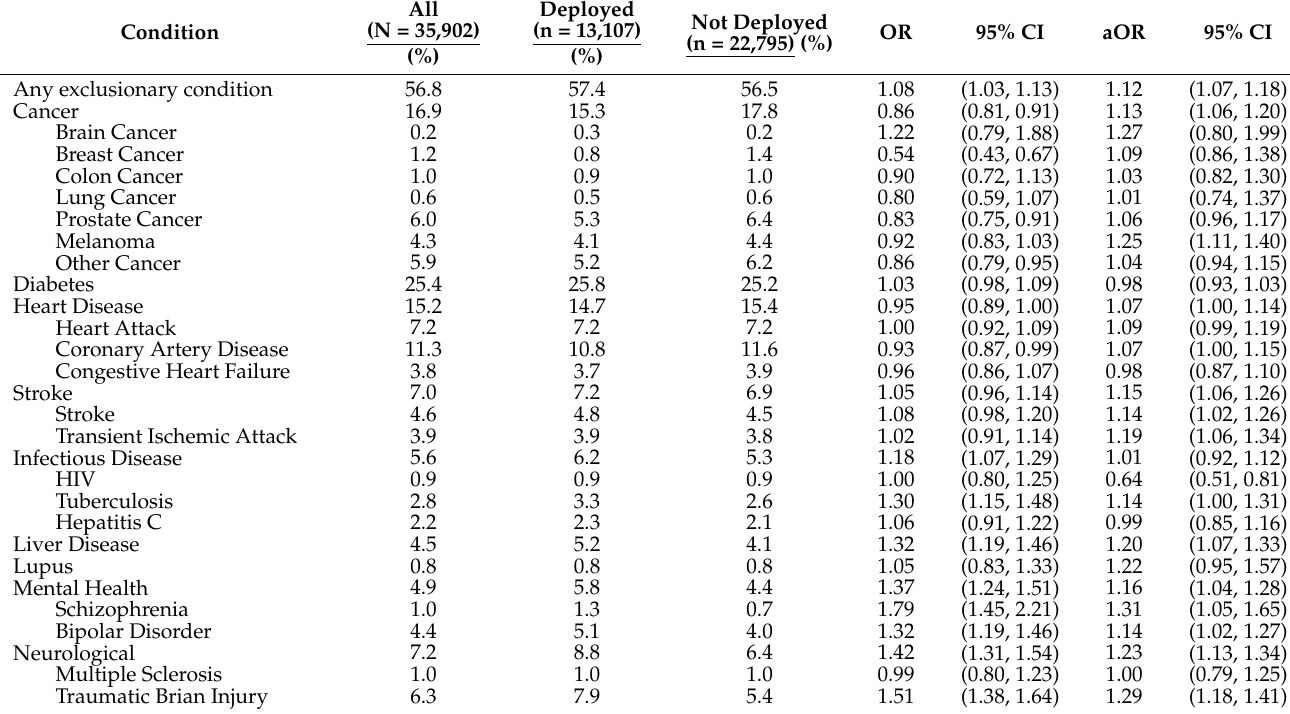
Table 3. Frequency and Associations of Veteran-Reported Exclusionary Conditions by 1990–1991 Gulf War Deployment